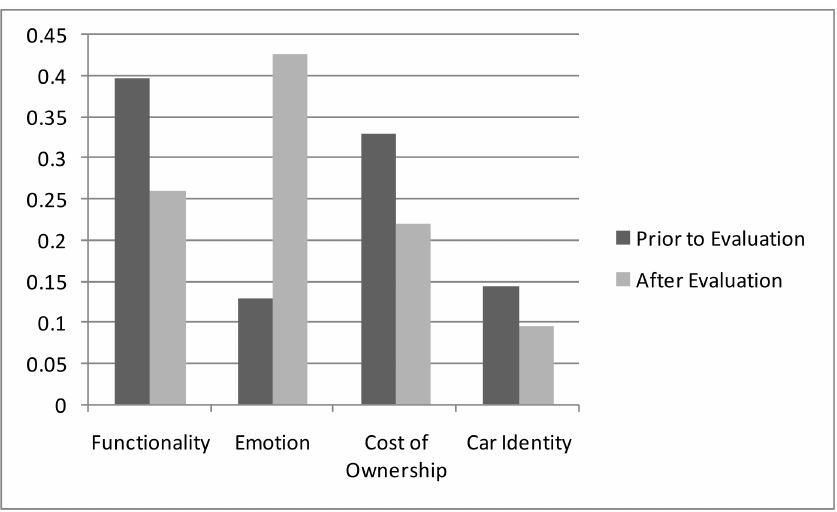
Figure 3. The weight of criteria before and after BEV